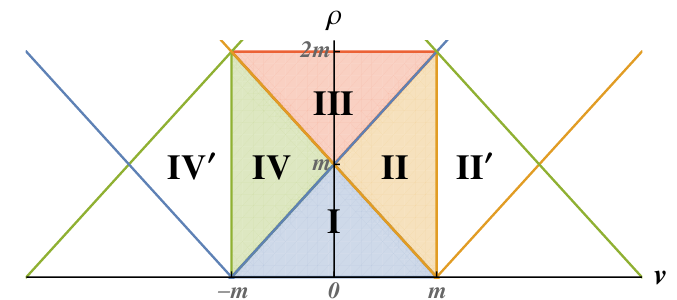
Figure 6. Quadrangle 0 < (cid:26) < 2 m;